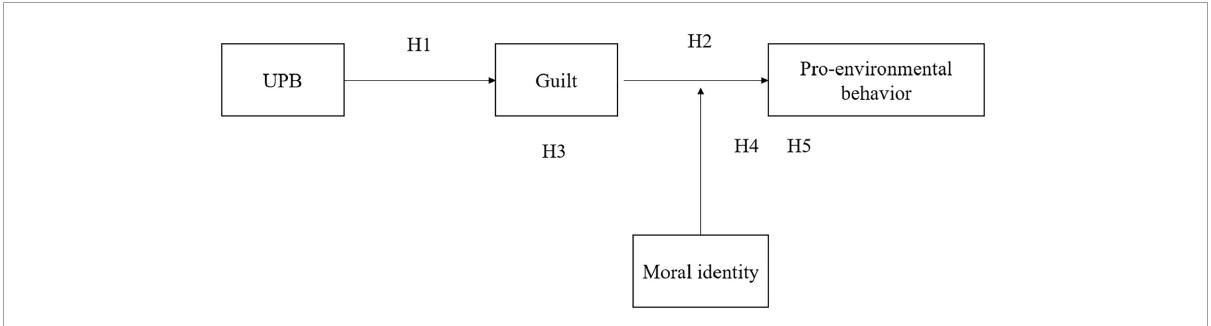
FIGURE1 The hypothesized